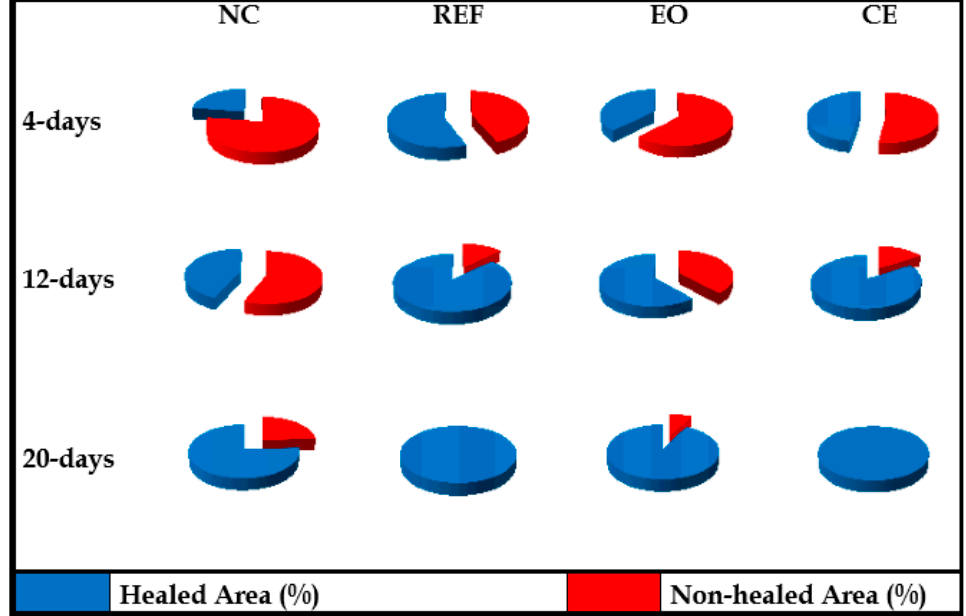
Figure 3. Photograph of wound area after topical application of Fucidin cream (REF) and essential oil (EO) and chloroform extract (CE) creams of Commiphora gileadensis in rats.